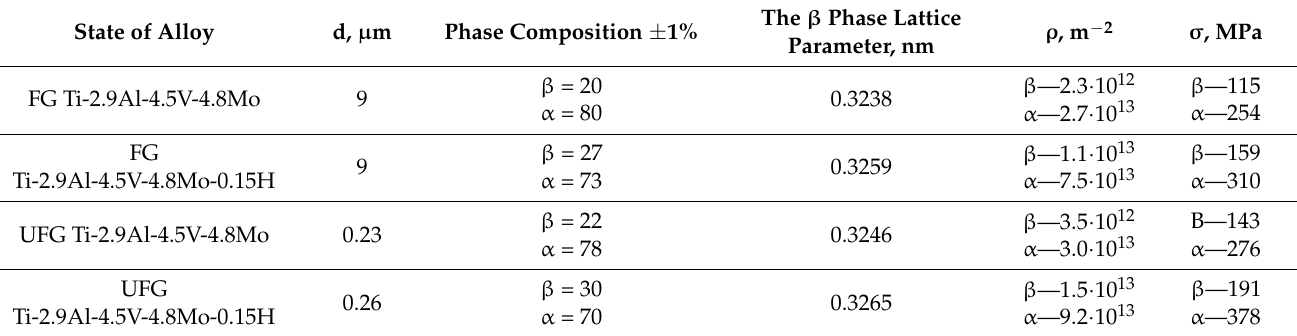
Table 1. Results of X-ray diffraction analysis for samples of the titanium alloys in different